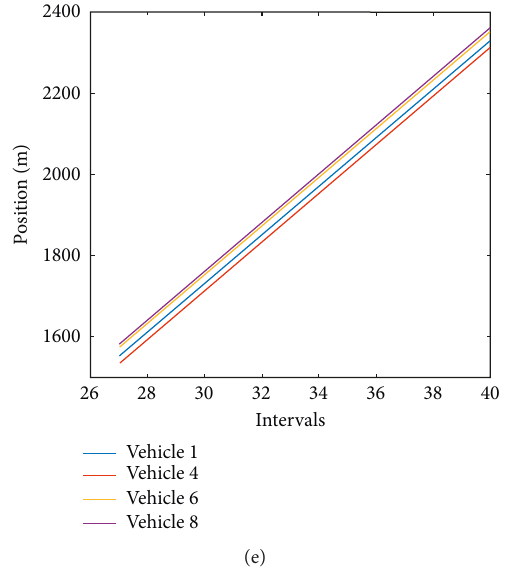
Figure 5: Vehicles trajectories on lane 1: (a) 2–10 s, (b) 10–18s, (c) 18–22s, (d) 22–54 s, and (e) 54–80s.